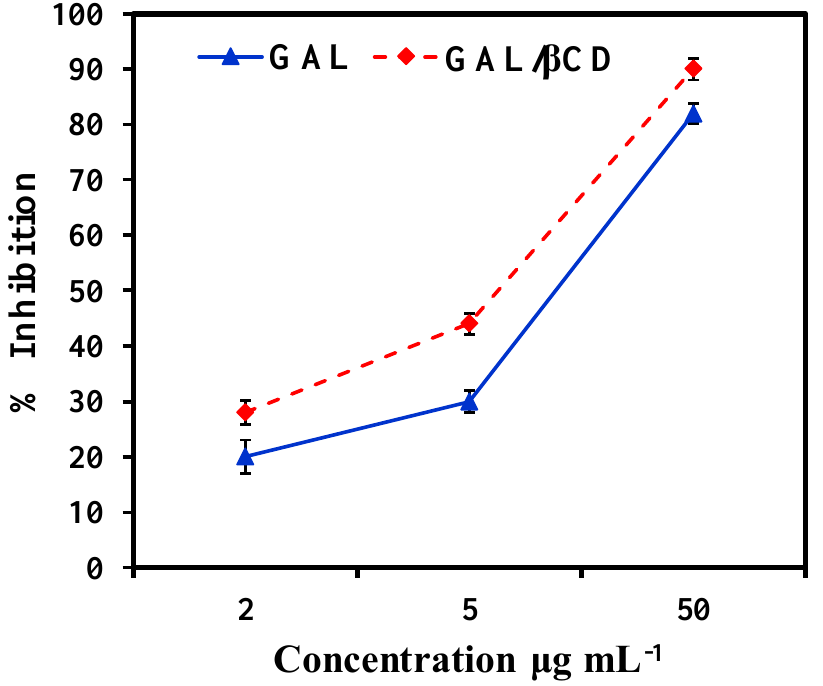
Figure 4: Effect of pure galangin (Blue color) and galangin /β-cyclodextrin (Red color) on xanthin oxidase activity at three different concentrations.